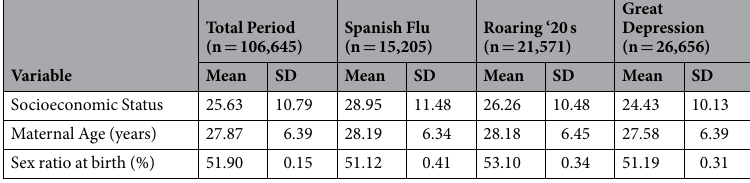
Table 1. Descriptive data summaries for variables and time periods under